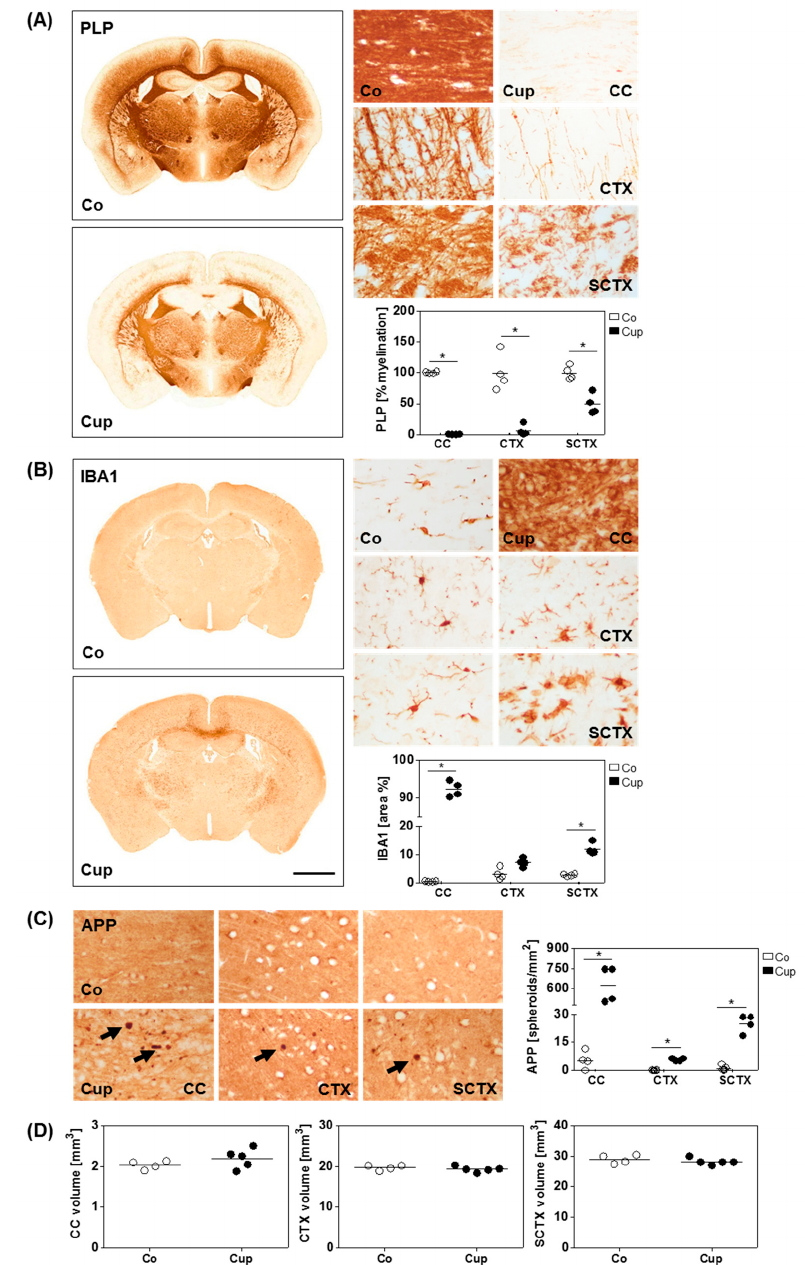
Figure 2. Acute demyelination does not lead to volumetric changes. ( A ) Quantification of myelination (anti-myelin proteolipid protein (PLP)) and ( B ) microgliosis (anti-ionized calcium-binding adapter molecule 1 (IBA1)) from controls (Co) ( n = 4) and five weeks of cuprizone-intoxicated (Cup) mice ( n = 4). Individual brain regions are shown in higher magnification: medial corpus callosum (CC), cortex (CTX), and subcortical area (SCTX). ( C ) Quantification of axonal damage (anti-amyloid precursor protein (APP)) with representative pictures of the medial CC, CTX, and SCTX from Co and Cup mice. Arrows indicate APP + spheroids. ( D ) Volumes of the CC, CTX, and the SCTX of Co ( n = 4) and Cup mice ( n = 5), analyzed with design-based stereology. Data are shown as individual values and means per group (lines). Statistical analysis revealed significant di ff erences between Co and Cup in ( A ) (CC, p = 0.03, CTX, p = 0.03, SCTX, p = 0.03), ( B ) (CC, p = 0.03; SCTX, p = 0.03), and ( C ) (CC, p = 0.02, CTX, p = 0.02, SCTX, p = 0.02); * p < 0.05. Scale bar in ( B ) = 2 mm ( A , B ) and 17 µ m (enlarged views ( A , B )) and